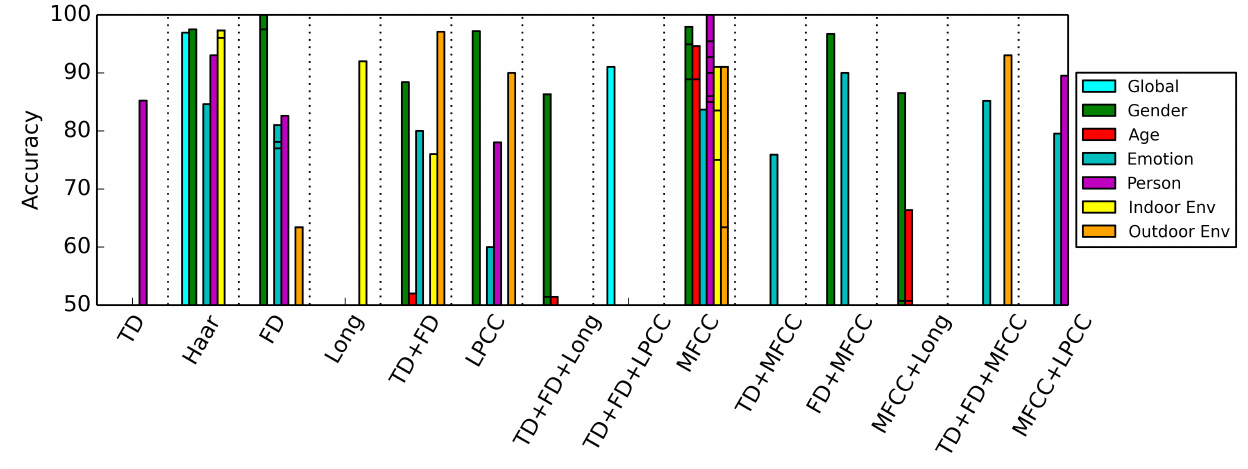
Figure 14. Overview of feature comparisons, grouped by